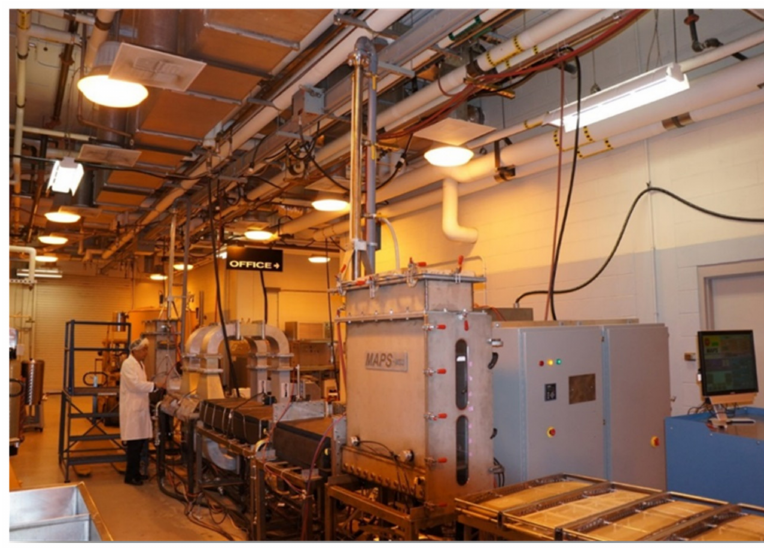
Figure 2. Pilot-scale 20 kW 915 MHz MAPs system at Washington State